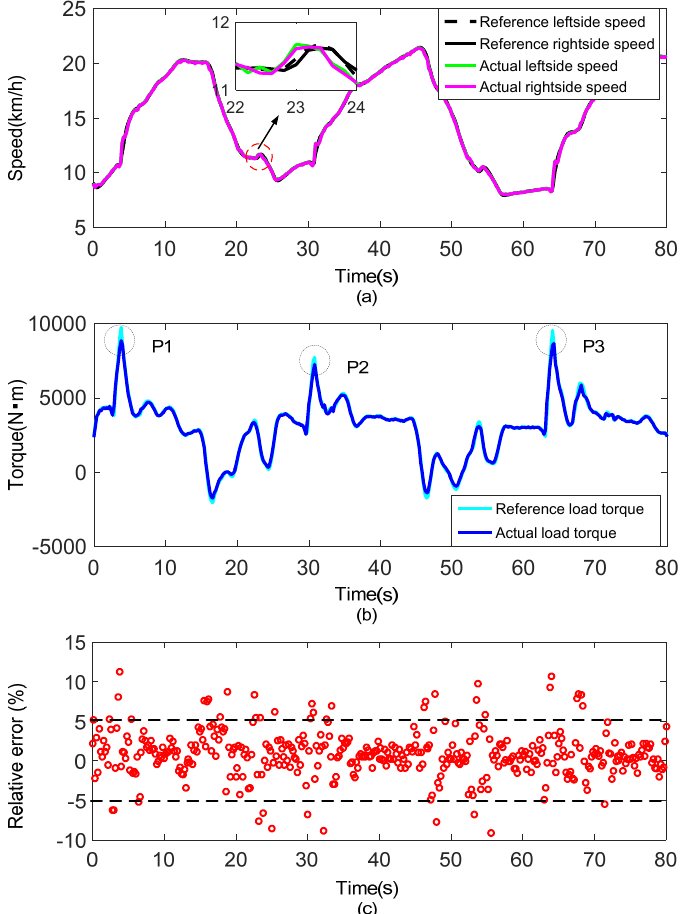
Figure 11. Experimental result under the driving condition of straight line with vehicle mass 20 t: ( a ) Speed tracking performance; ( b ) Comparison of total load torque of the vehicle; ( c ) Relative error of the load emulation (displayed by scatter plot).